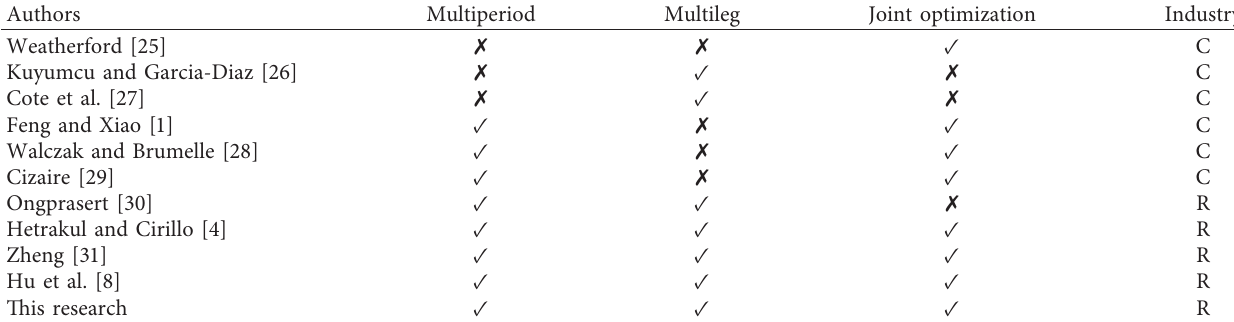
Table 1: Literature review summary of joint optimization of pricing and seat